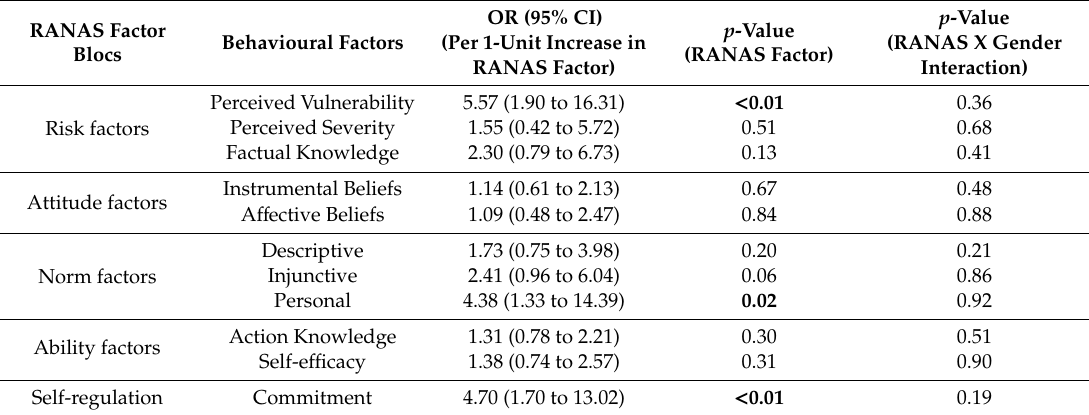
Table 5. Odds ratios (OR) and 95% confidence intervals (CI) derived from binominal logistic regression analyses as indicators of associations between RANAS components and experiential health behaviours following flooding among people with direct experience of flooding ( n = 80).